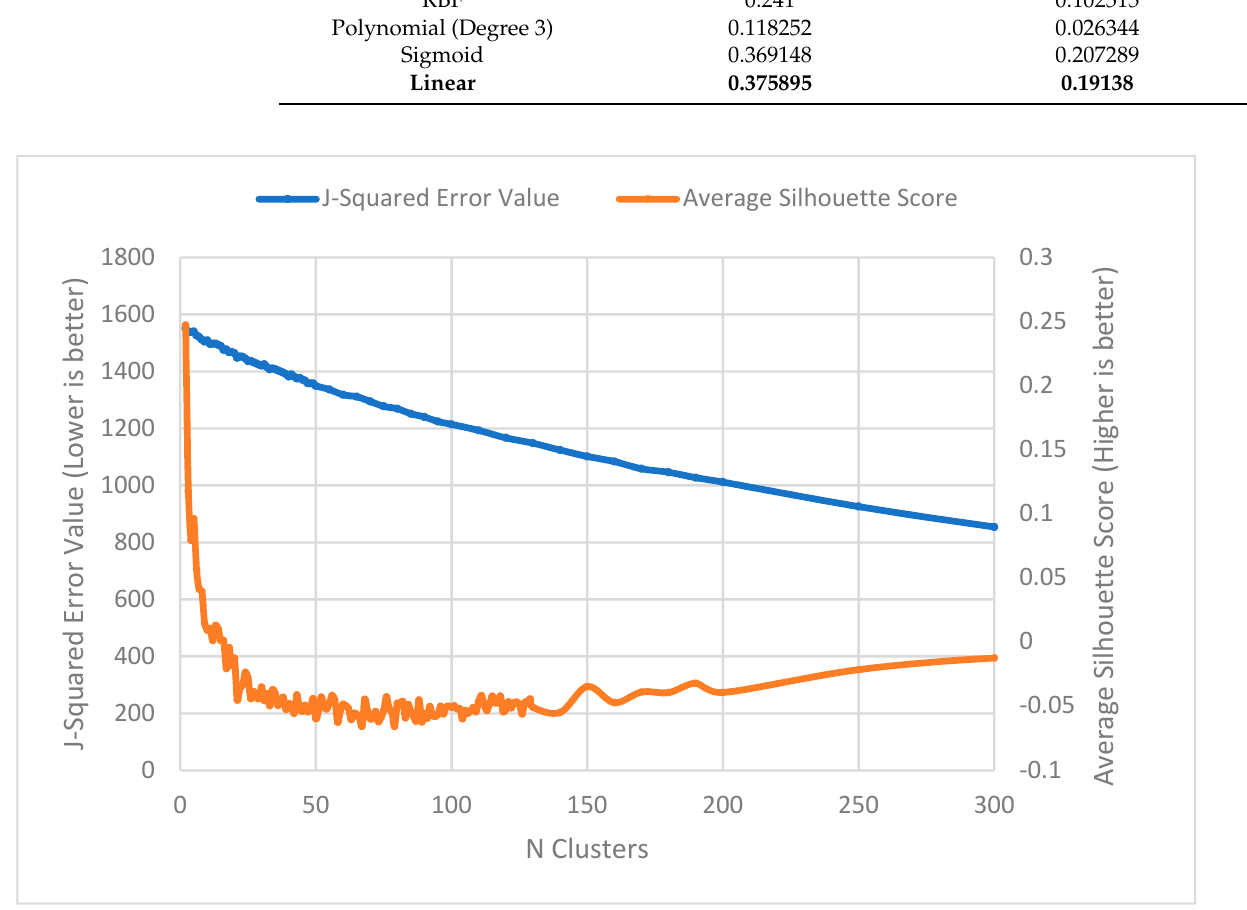
Figure A1. K—Means Tuning Graph. Comparison of how the j-squared error and average silhouette score vary for differing numbers of clusters ( k ).